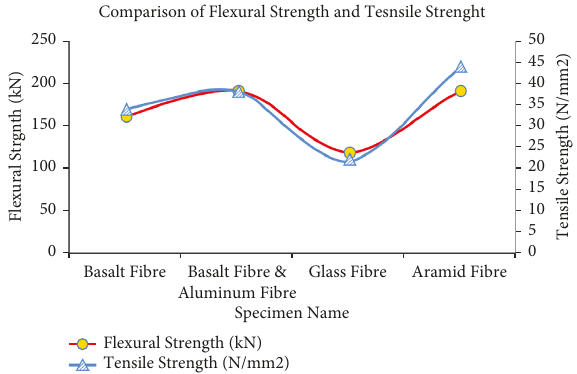
Figure 9: Comparison of flexural strength and tensile